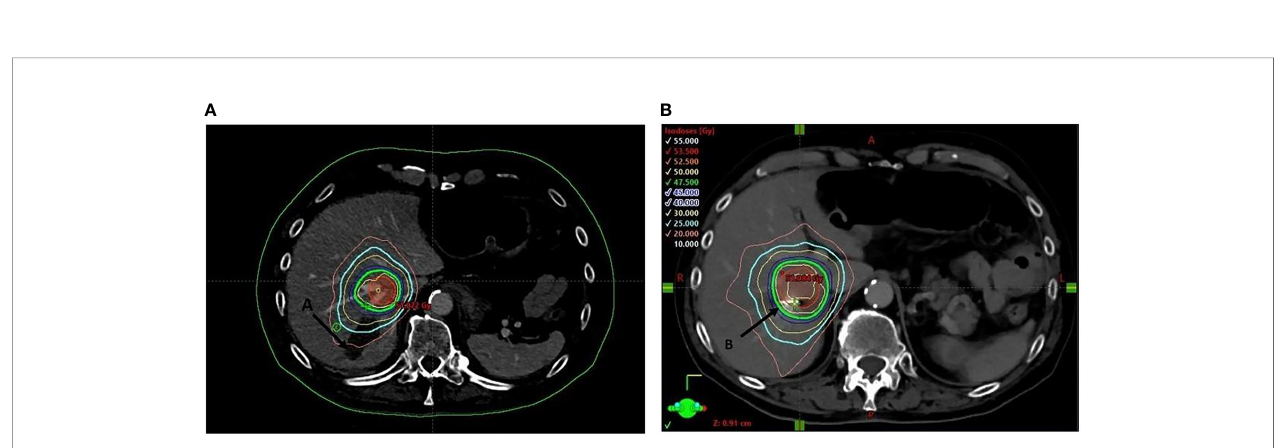
FIGURE 4 | Dose distribution of the stereotactic body of radiotherapy (50 Gy in fi ve fractions) of lesion (B) (coils) post radiofrequency of lesion (A)